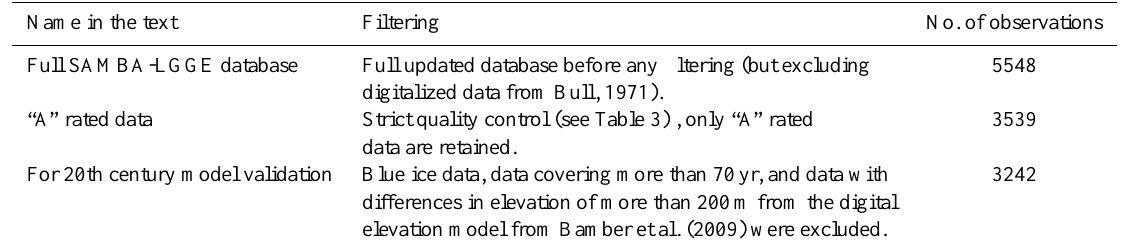
Redundant data from (Higham and (traverse to Dome A) Craven, 1997) are stakes measurements Higham and Craven (1997) spanning only 1yr: these redundant data disappear after the quality control.